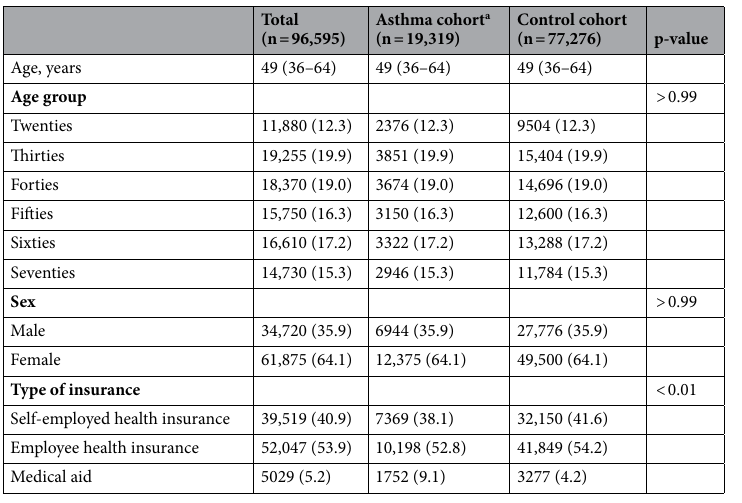
Table 1. Baseline descriptive characteristics of the study population. Data are presented as frequency (%) and mean with standard deviation. COPD, chronic obstructive pulmonary disease. a Asthma-related medication included inhaled corticosteroid (32%), long-acting β2 agonist (19.1%), short-acting β2 agonist (34.8%), and leukotriene receptor antagonist